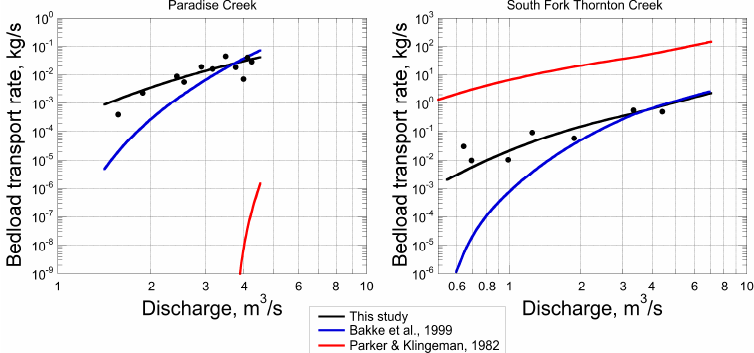
Figure 6. Total bedload transport versus discharge. The site-calibrated model described in this study (black line) is contrasted against the method of Bakke et al. [20] (blue line) and use of the original values of the hiding factor equation constants from Parker and Klingeman [3] without calibration (red line). Paradise Creek, shown on the left, has relatively low shear stress during bedload transporting events compared to the South Fork Thornton Creek, on the right, resulting in a striking difference between uncalibrated versus calibrated model performance.